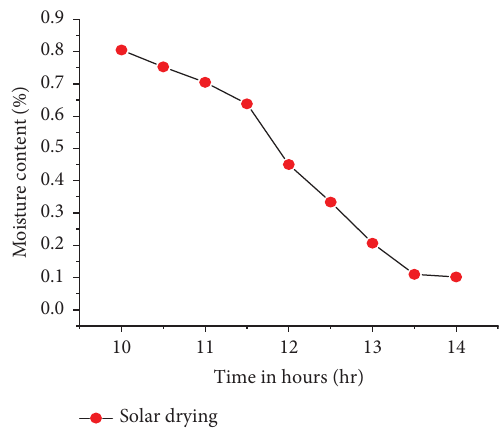
Figure 7: Drying characteristics of ginger with respect to drying time.